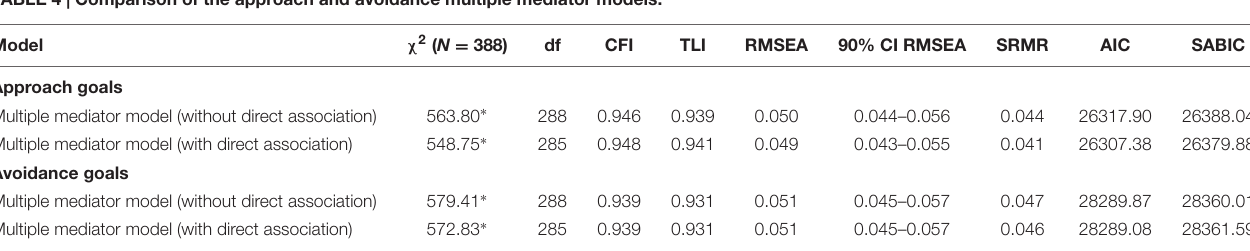
TABLE 4 | Comparison of the approach and avoidance multiple mediator